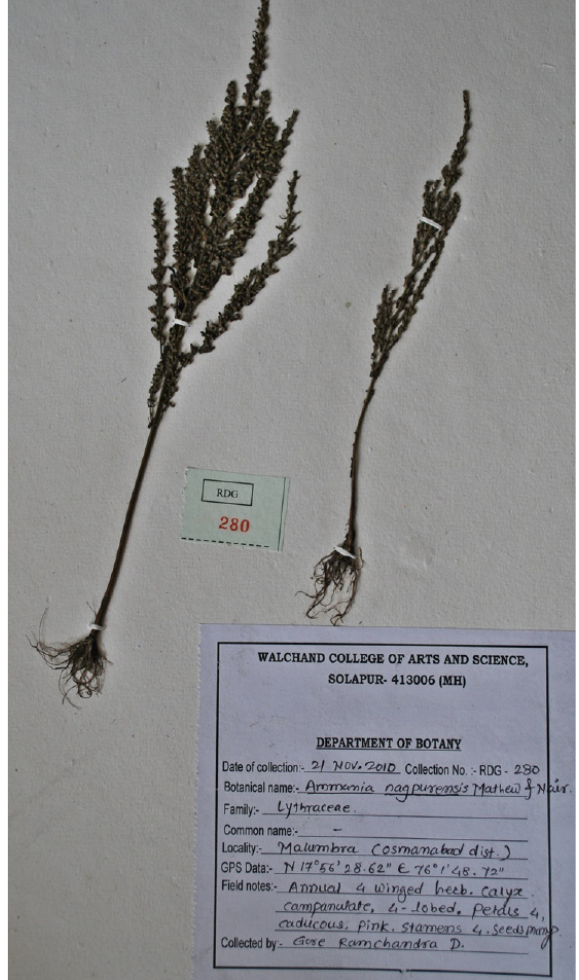
Image 7. Ammania